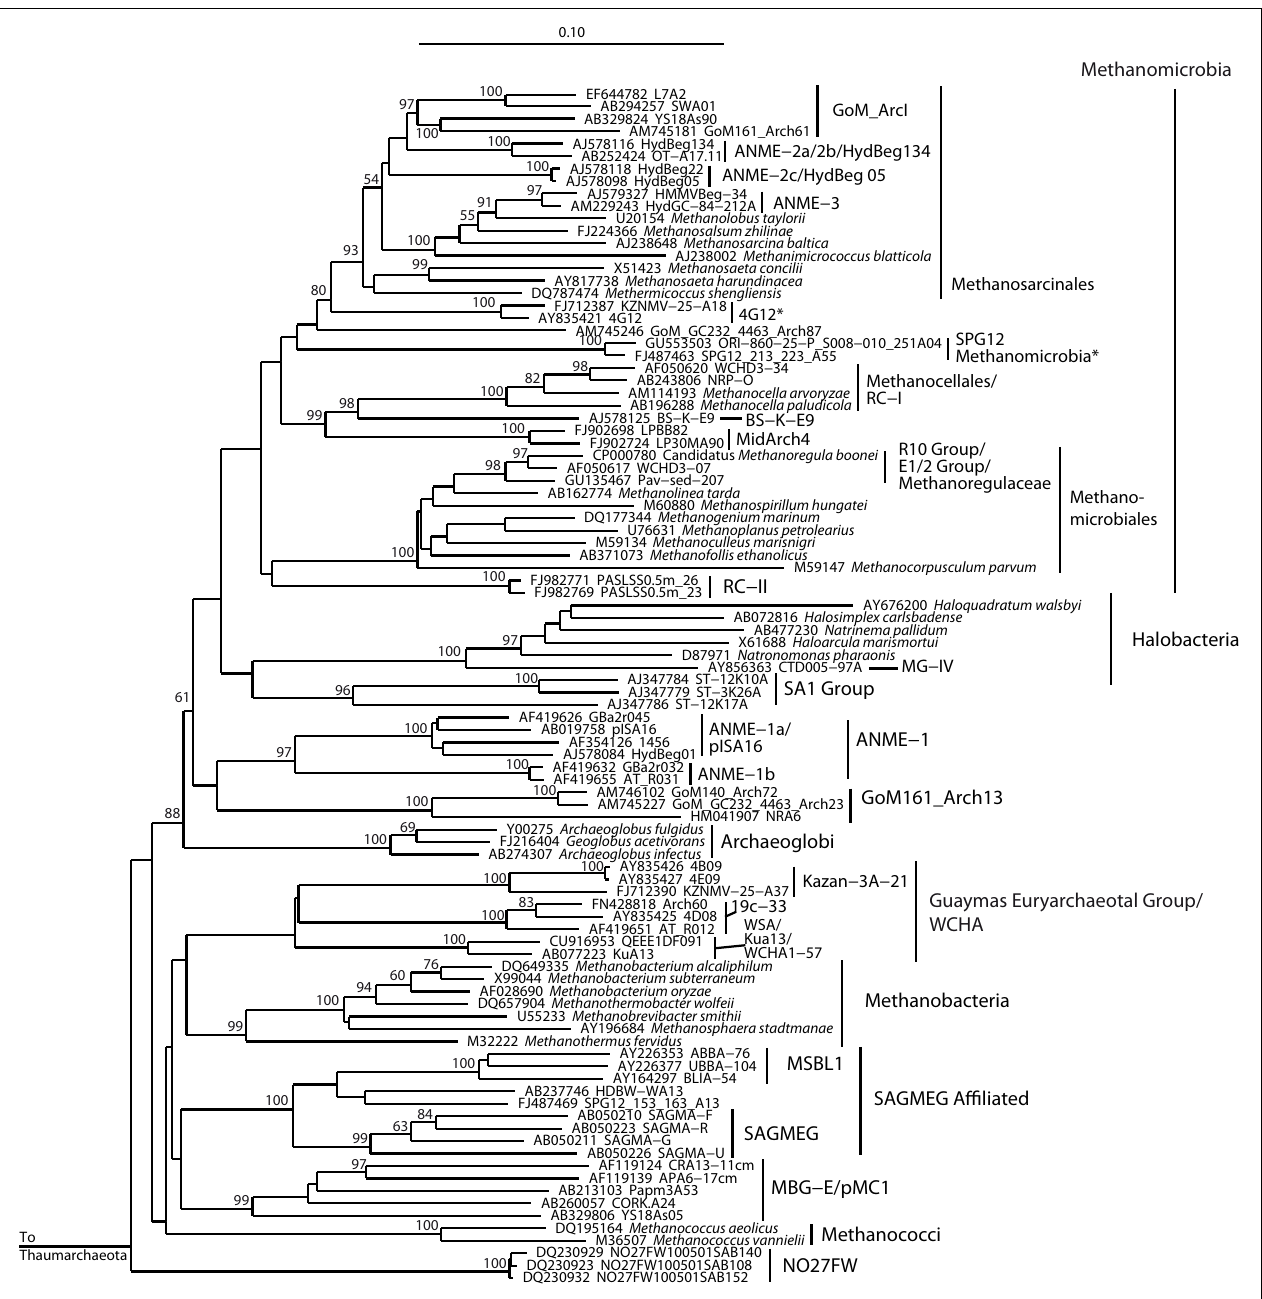
(Jobb et al., 2004). Branches are annotated with names and acronyms that are used in the literature ( Table 3 ).The archaeal taxa marked with asterisks are novel designations introduced either in Durbin andTeske, 2011 or in this study ( Table 3